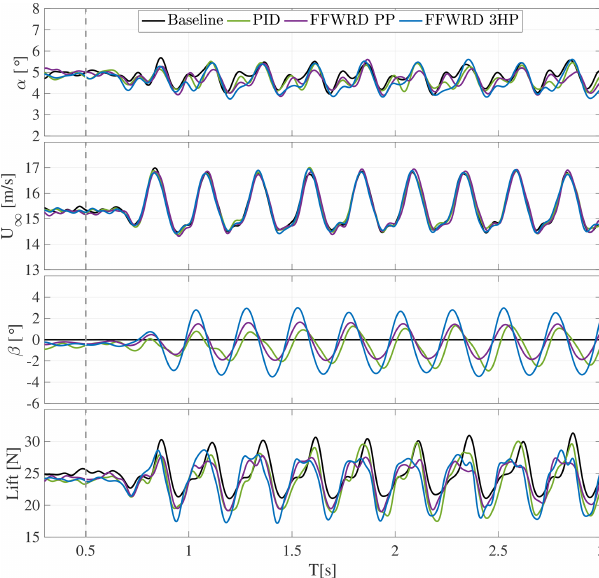
Figure D4. Time series of angle of attack and velocity variation, flap motion, and resulting lift amplitude at a reduced frequency of k = 0 .